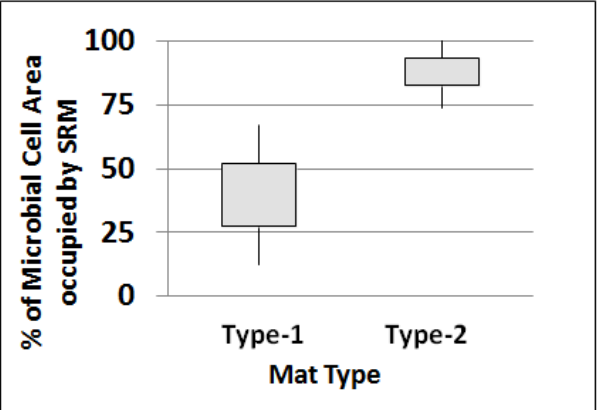
SRM. Results show that in Type-2 mats, over 80% of microbial cells (based on area occupied) were SRM. Note: Type-1 mats ( n = 21) and Type-2 mats ( n = 31); tails represent 95% confidence intervals (CI).